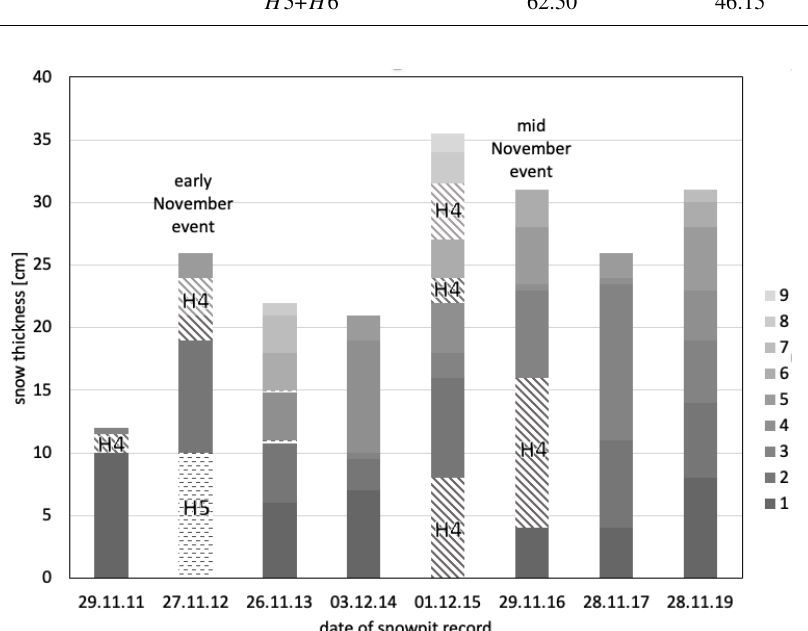
Figure 10. Snowpit observations at the IOA site (Sodankylä) in late November/early December. Years with rain-on-snow events detected through ASCAT and SMOS are indicated (see also Fig. 3). Individual layers are represented through grey gradients. Hardness 4 layers are highlighted with diagonal hashes and hardness 5 with horizontal dashed